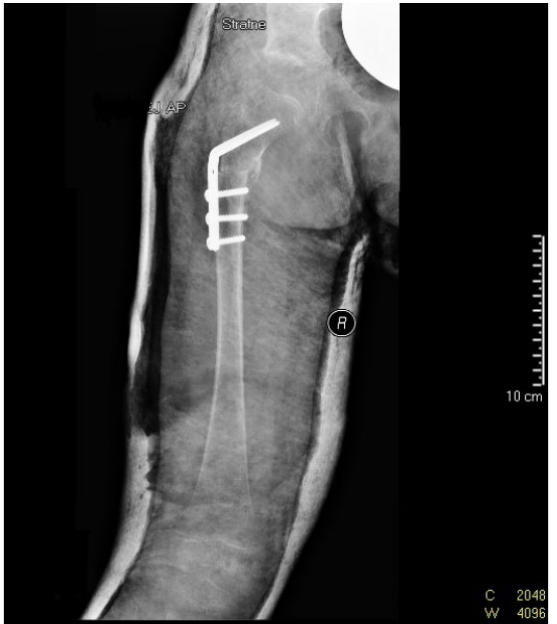
Figure 5. X ‐ ray scan following varus and de ‐ rotative osteotomy on the proximal part of the right Figure 5. X-ray scan following varus and de-rotative osteotomy on the proximal part of the right femoral bone (at 6 years of age). femoral bone (at 6 years of